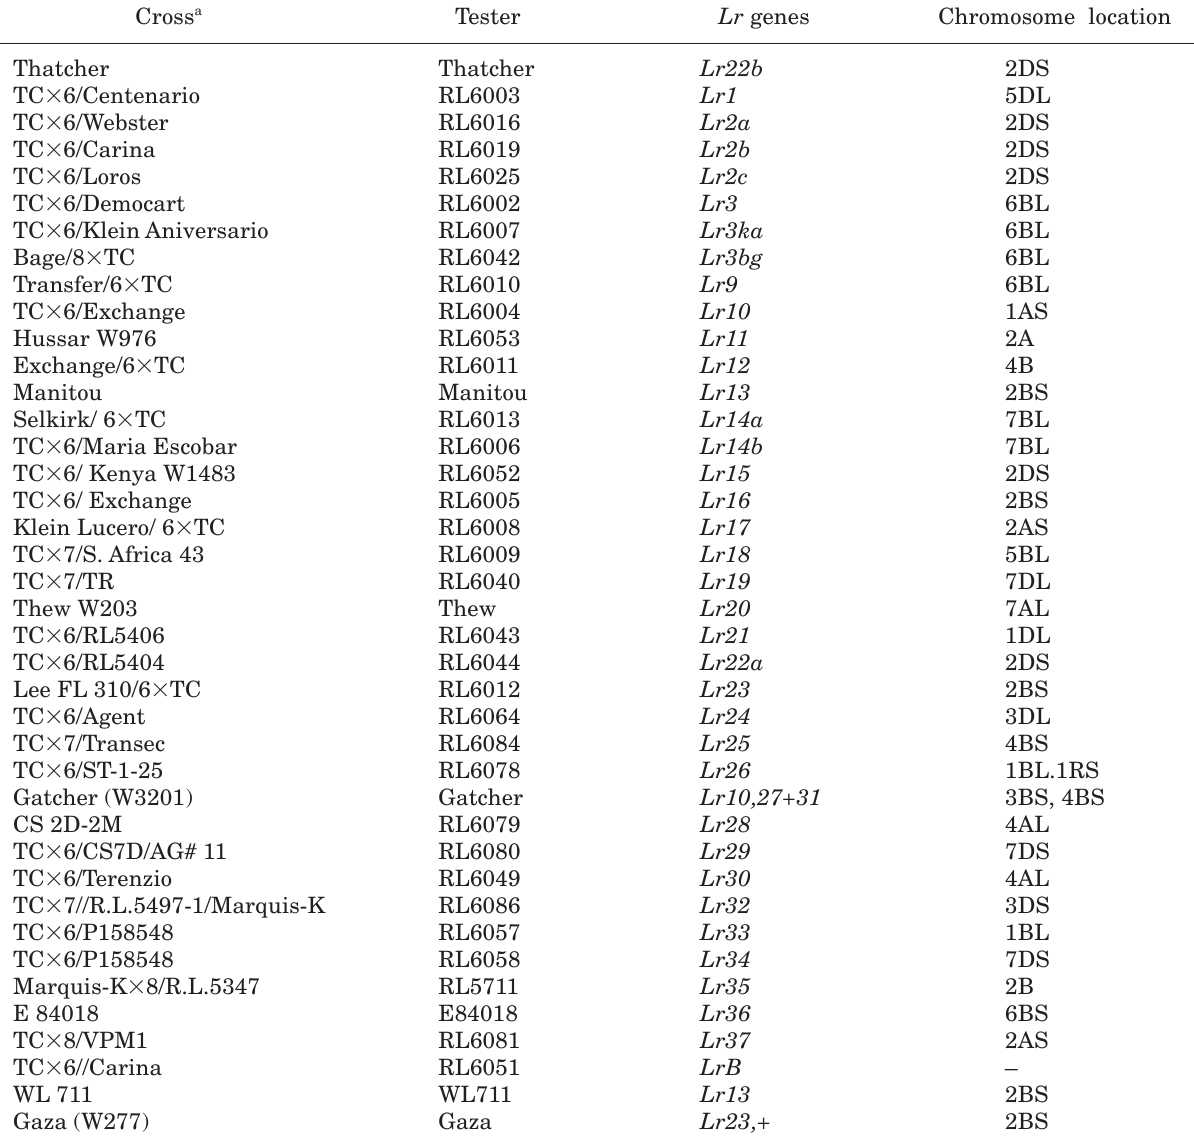
Table 1. Host tester series with named Lr genes for brown (leaf) rust resistance and their chromosomal location. Cross a Tester Lr genes Chromosome